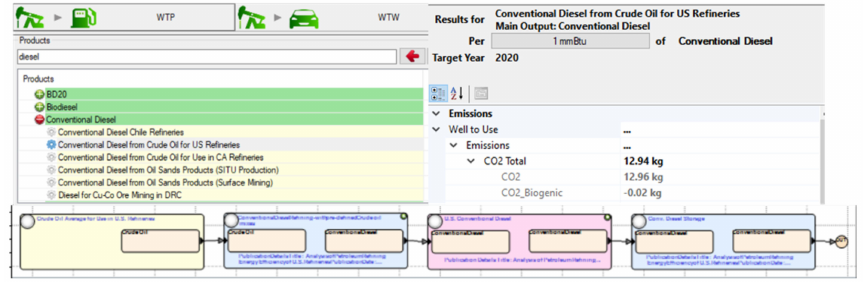
Figure 5. LCA results for conventional diesel produced from crude oil.